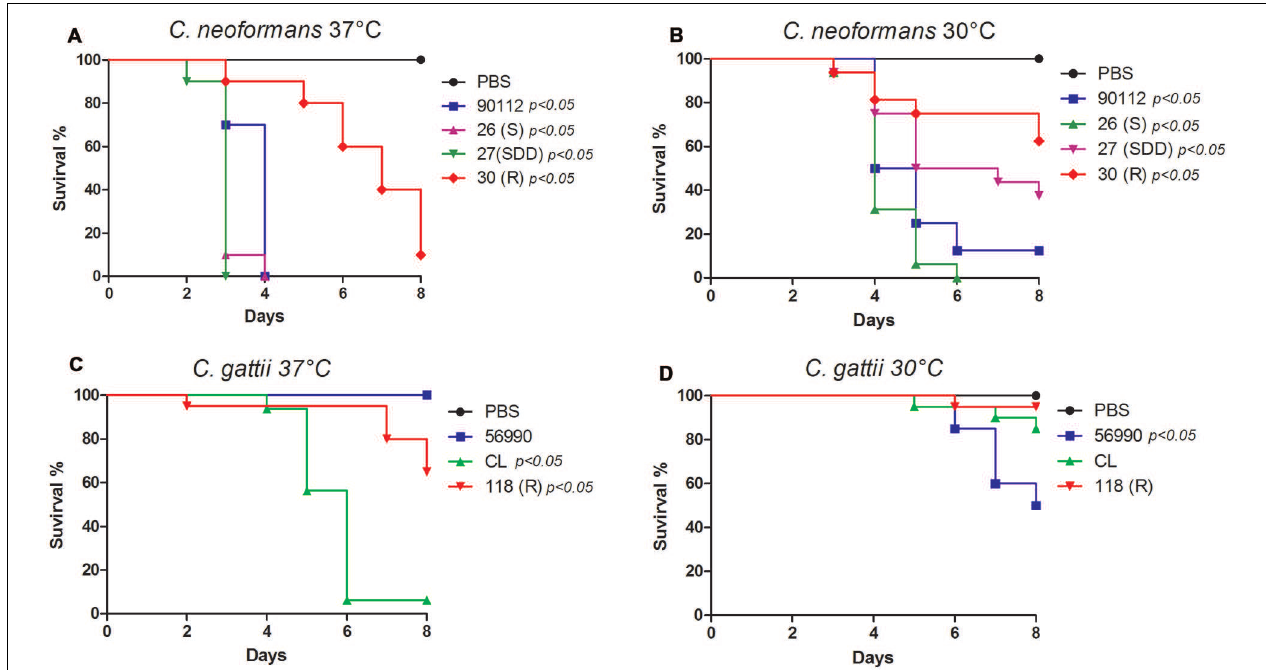
FIGURE 2 | Virulence assay in Galleria mellonella . (A) Sequential clinical isolates of C. neoformans , 26S, 27SDD, and 30R incubated at 37 ◦ C; (B) Sequential clinical isolates of C. neoformans , 26S, 27SDD, and 30R incubated at 30 ◦ C; (C) Environmental isolates of C. gattii 118R and CL incubated at 37 ◦ C; (D) Environmental isolates of C. gattii 118R and CL incubated at 30 ◦ C.